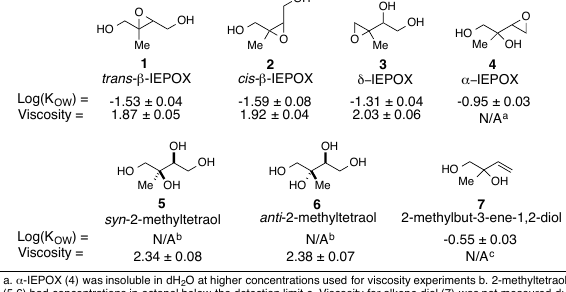
Figure 1. Octanol-water partition coefficients and viscosity values for epoxides 1–4 and 346 Figure 1. Octanol–water partition coefficients and viscosity values for epoxides 1–4 and tetraols 5 and